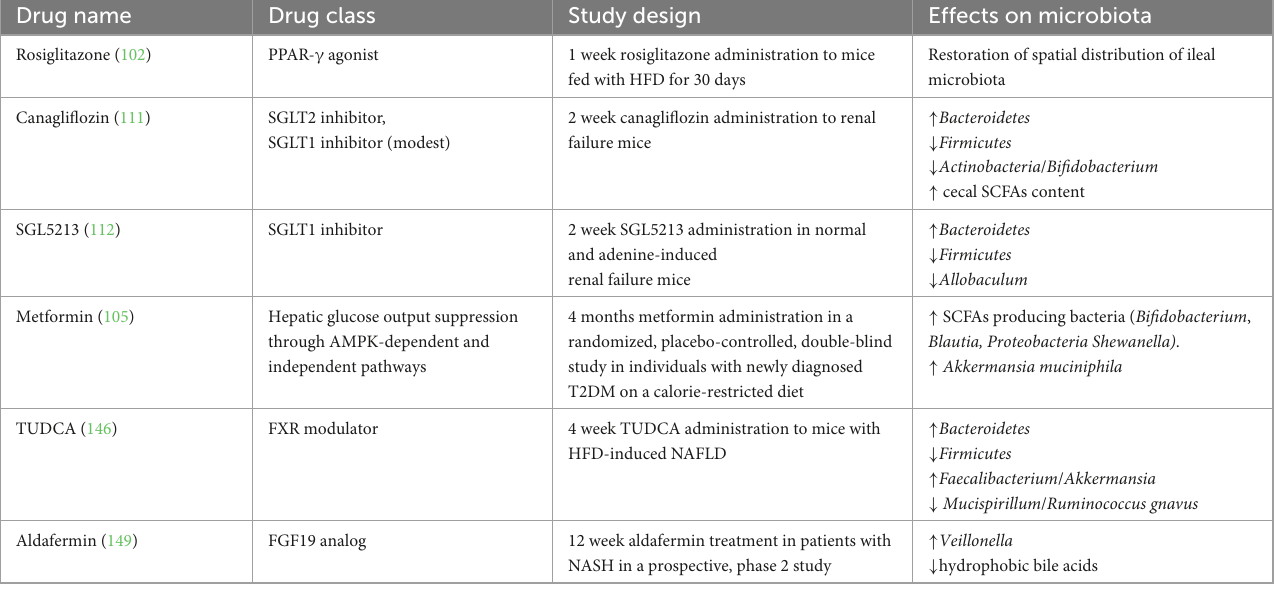
TABLE 1 Studies investigating the effect of anti-diabetic drugs and farnesoid X receptor (FXR) modulators on the gut microbiota. Drug